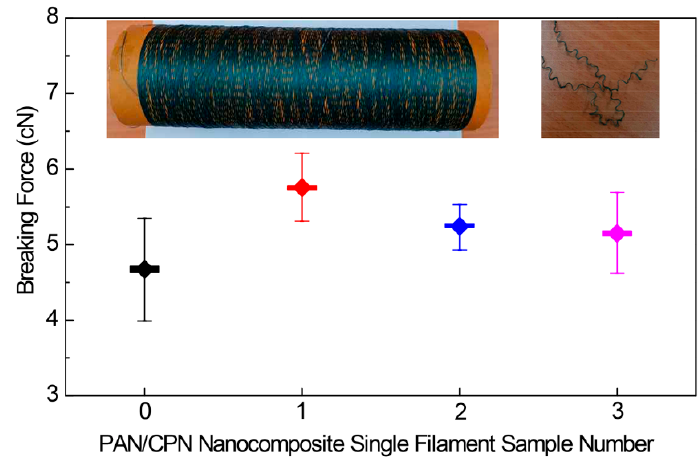
Figure 7. Infrared thermal images of B2 under white light irradiation at ( a ) t = 0 s and ( b ) t = 600 s, and ( c ) 600 s after turning off the light. The photothermal response of the textiles fabricated using ( d ) PAN and ( e ) PAN/CPN nanocomposite fibers at 0.75 wt % of CPNs under white light irradiation for the first 600 s, followed by 600 s after turning off the light.